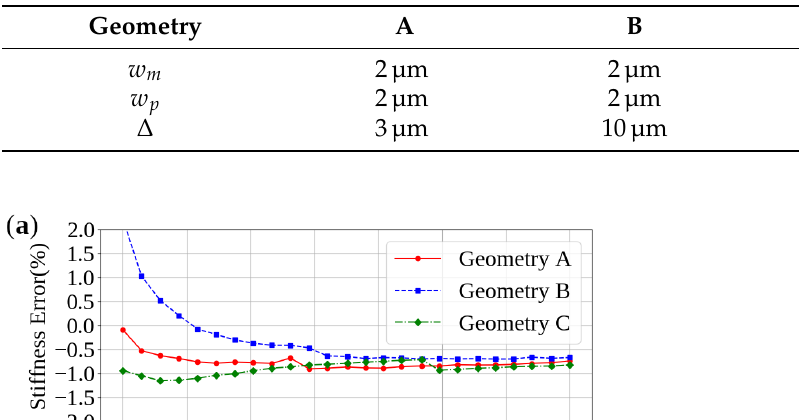
Table 1. Dimensions of geometries tested